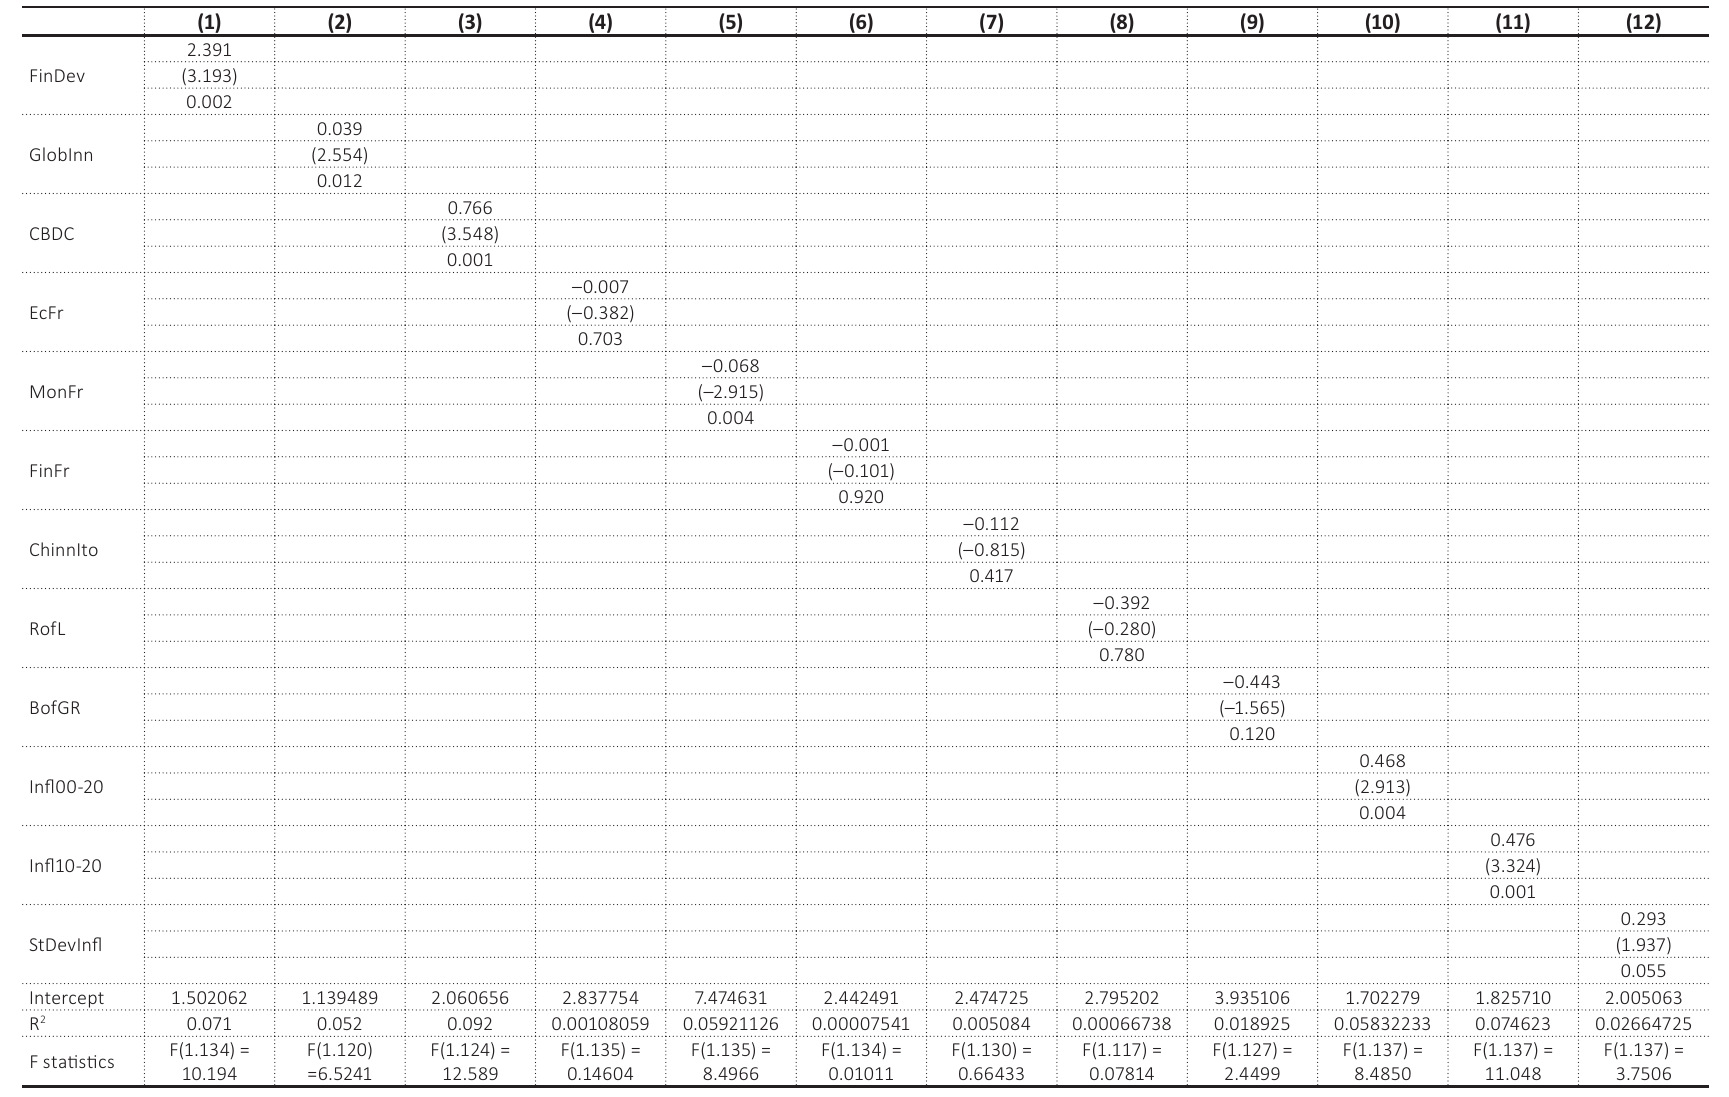
Table 1. Single-factor regression analysis